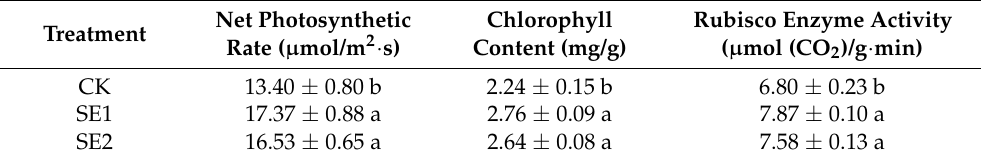
Table 1. Effects of organic fertilizer on the net photosynthetic rate, chlorophyll content, and Rubisco activity in ‘Fuji’ apple leaves. Treatment